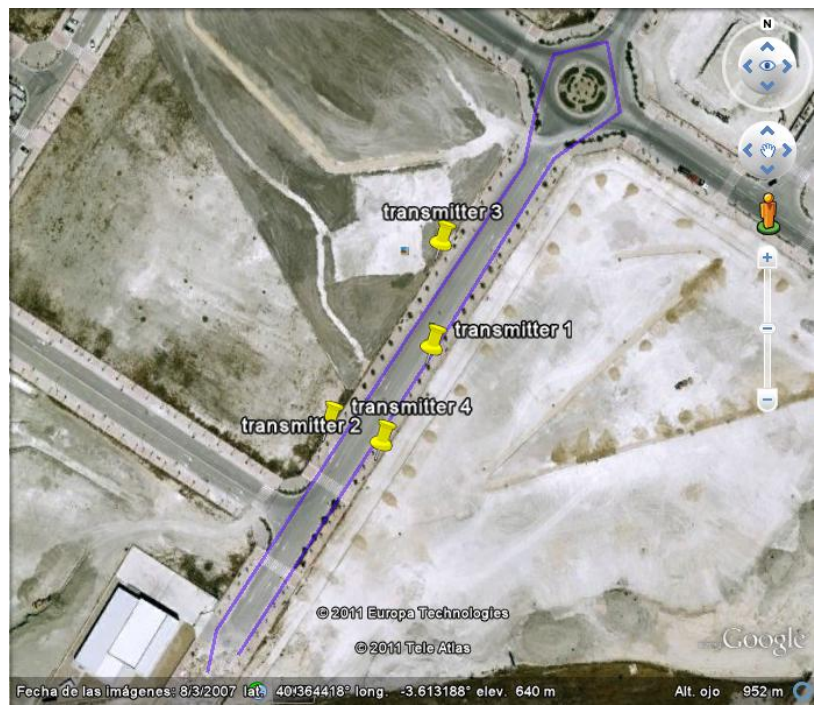
Figure 15. Test-bed. In violet color, the path of the car. In yellow, the four